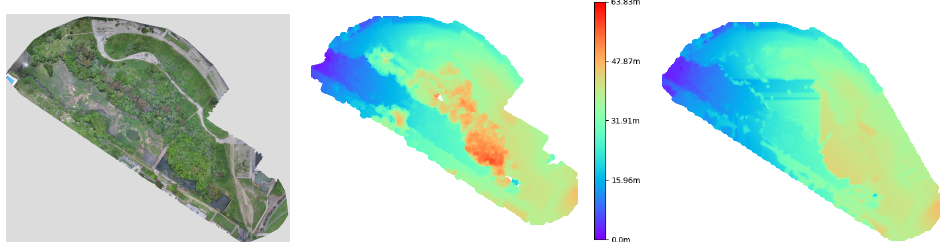
Figure 15. Original orthomosaic of the relevated area ( left ), DTM estimated with the Default algorithm of ODM ( middle ) and DTM corrected with our method ( right ).